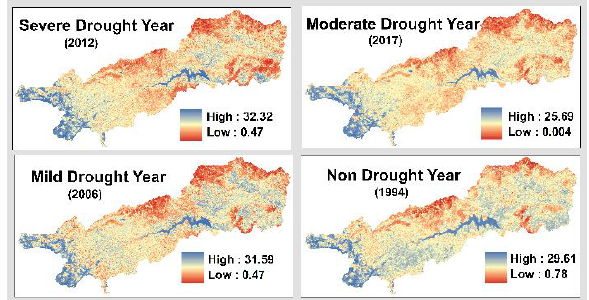
Figure 5. Variation in temperature conditions index during different drought intensity and non-drought conditions.